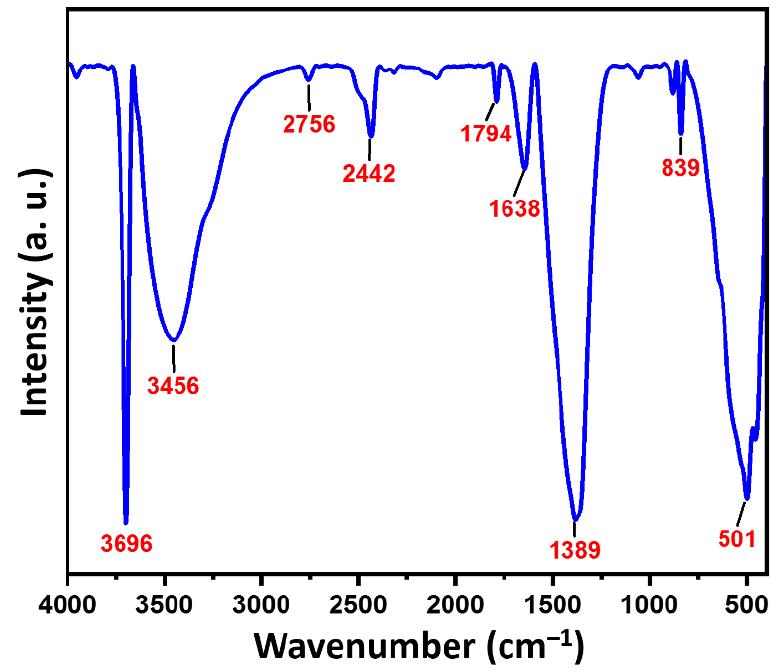
Figure 2. FTIR spectrum of MgO NBs.